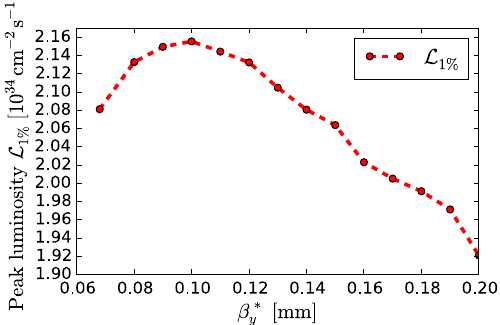
FIG. 7. Peak luminosity maximization versus β (cid:1) y for L (cid:1) ¼ 6 m.